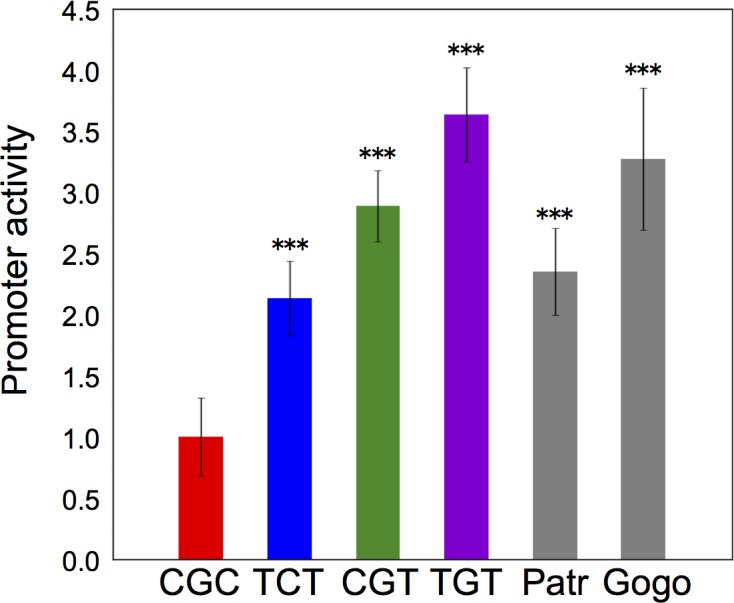
Promoter activities of the human, chimpanzee and gorilla ST8SIA2 promoter types measured by luciferase expression.Each value represents mean ± standard error of the mean over six independent transfection experiments. Data are represented as relative fold-increase compared with the human CGC-type. Chimpanzee (Patr) and gorilla (Gogo) possess the TGT-type promoter.